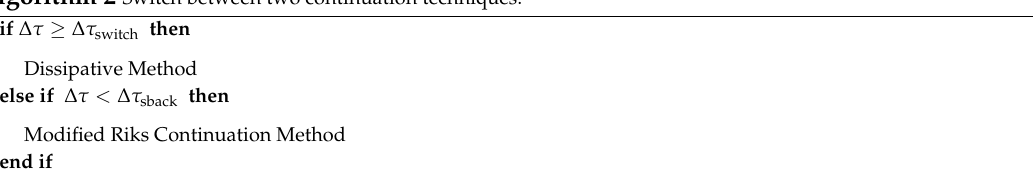
Algorithm 2 Switch between two continuation